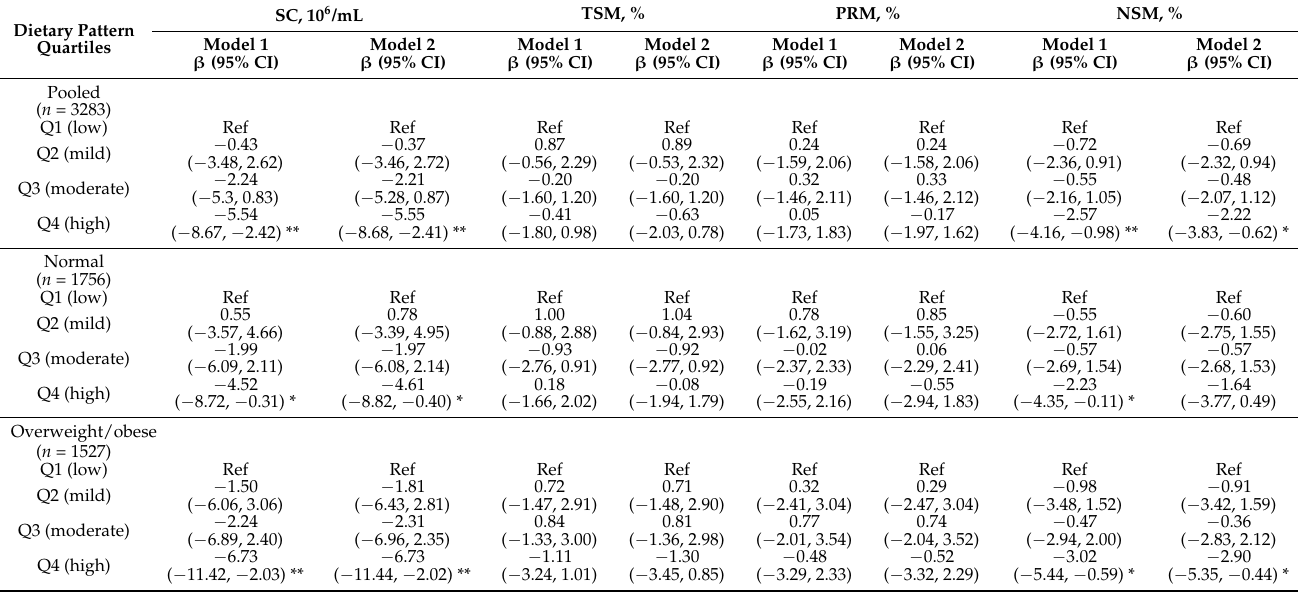
Table 5. Multivariate linear regression coefficients for sperm parameters in relation to the dietary pattern quartiles according to nutrition